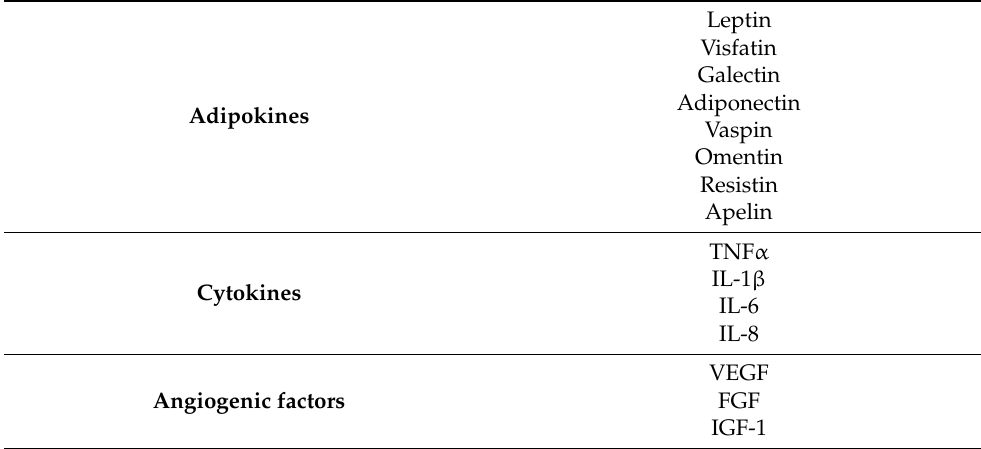
Table 1. Inflammatory, metabolic and angiogenic factors secreted by the adipose tissue.